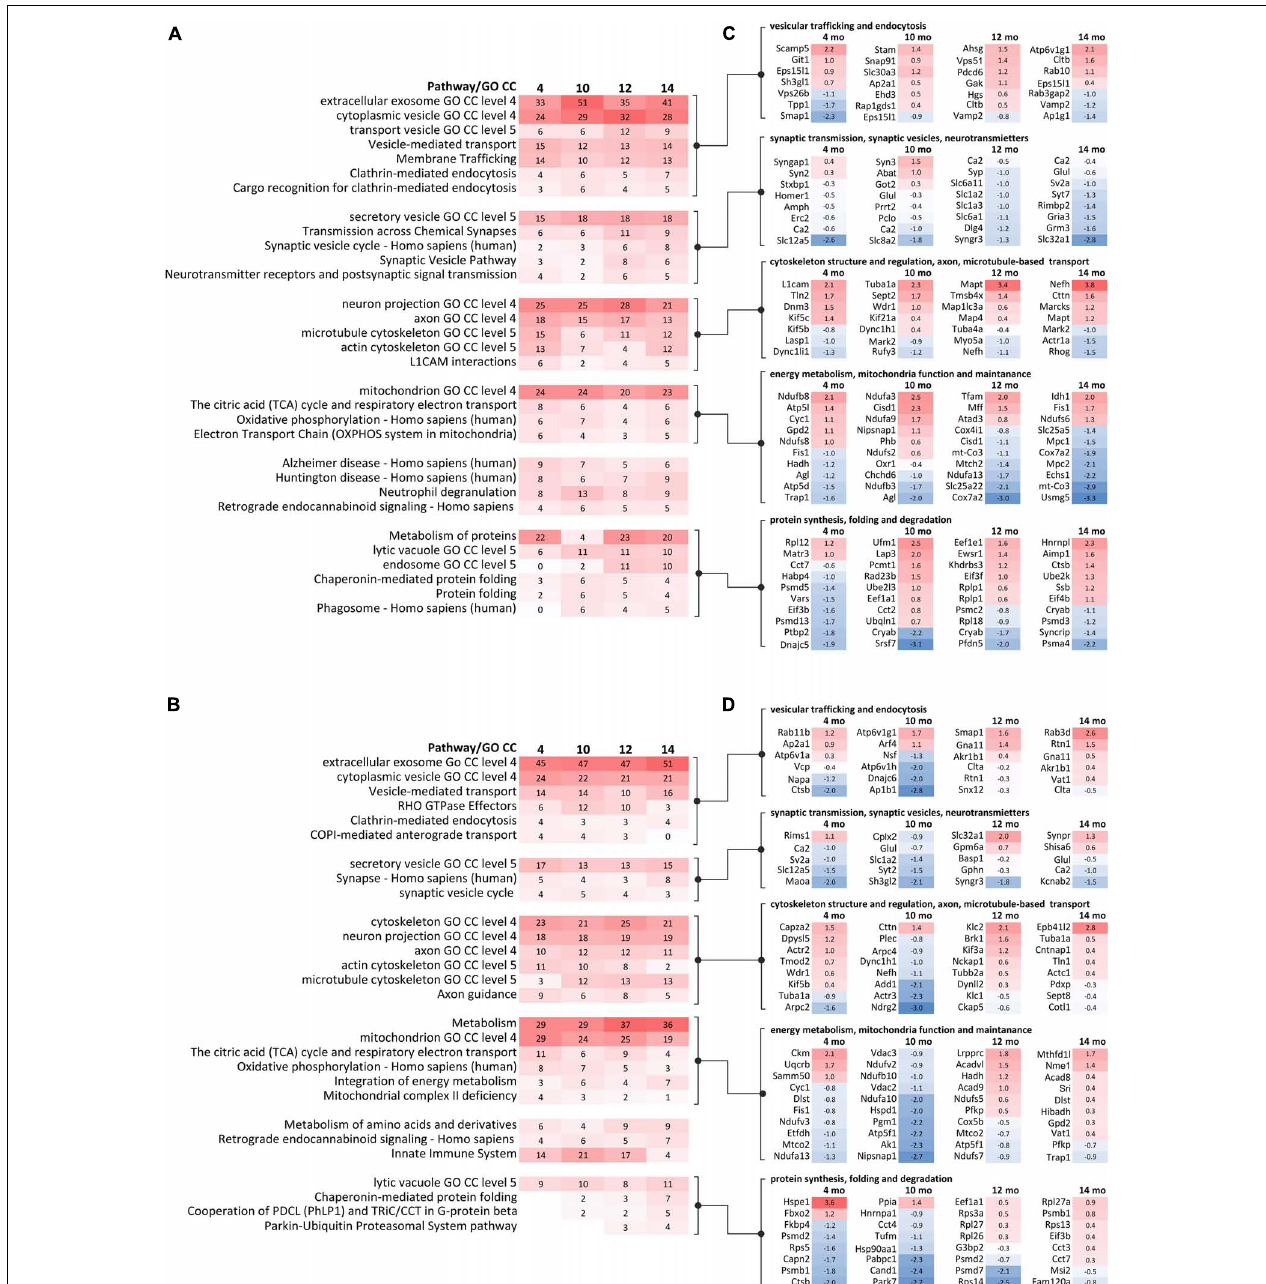
FIGURE 4 | GO term and pathway analysis of dysregulated proteins identified in proteomics at behavioral milestones in the Ki91 SCA3/MJD mouse brain implicate vesicular transport, cytoskeleton, protein metabolism, and mitochondrial function. Bioinformatic analysis of biological pathways and subcellular localization of dysregulated proteins ( p < 0.05; two-sample t -test, n = 4 per genotype) during disease progression in the cerebral cortex (A) and cerebellum (B) was assessed using ConsensusPath database (CPDB; pathways p -value cut-off < 0.01; GO terms cellular component, p -value cut-off < 0.01, level 3, 4). The heatmaps present changes of pathways and subcellular localization involving dysregulated proteins ( p < 0.05; two-sample t -test) over the course of the disease in four tested ages (4, 10, 12, and 14-month-old) by showing what percentage of dysregulated proteins in each set is assigned to the particular pathway or subcellular region (numbers). The gradient of red color denotes a higher percentage of dysregulated proteins (more intense color) to a lower percentage of dysregulated proteins (less intense color). The five groups of pathways and GO terms arranged in blocks in (A,B) are linked to the corresponding lists of dysregulated proteins ( p < 0.05; two-sample t -test) with the highest log2-FC in each tested age, assigned to five arbitrary categories in the cerebral cortex (C) and cerebellum (D) . The categories were formed based on the analysis of pathways and GO terms and are as follows: (1) vesicular trafficking and endocytosis; (2) synaptic transmission, synaptic vesicles, and neurotransmitters; (3) cytoskeleton structure and regulation, axon, and microtubule-based transport; (4) energy metabolism, mitochondria function, and maintenance; and (5) protein synthesis, folding, and degradation. The lists of dysregulated proteins are also presented as heatmaps with numbers representing log2-FC (C,D) . The gradient of red color is for upregulated proteins, blue color for downregulated proteins.